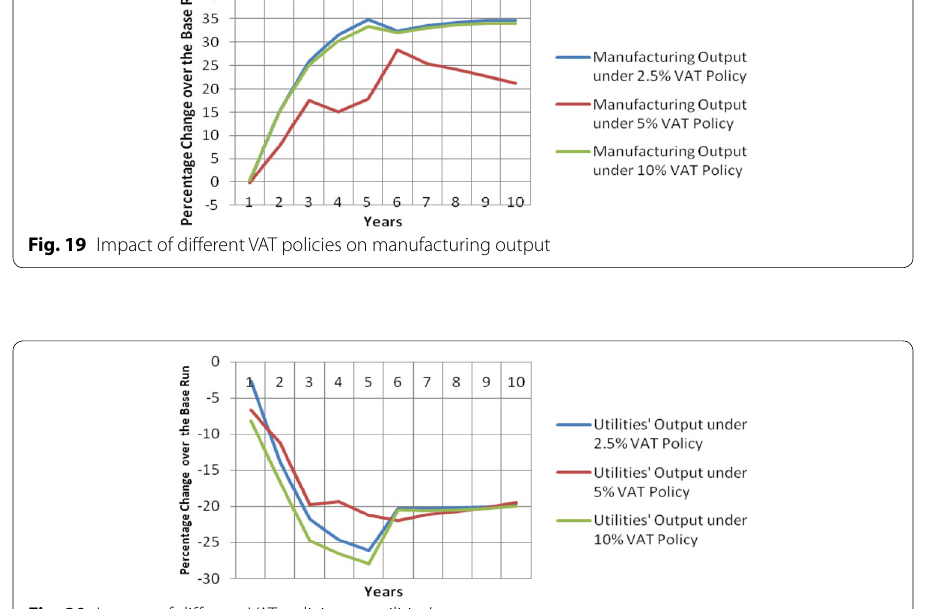
Fig. 20 Impact of different VAT policies on utilities’ output